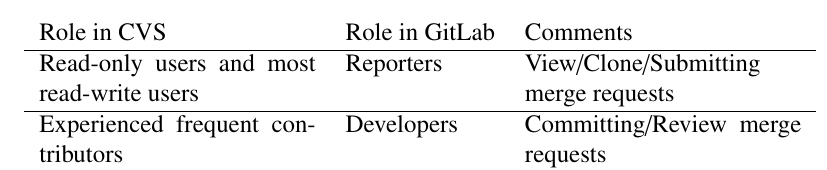
Table 1. Access Control